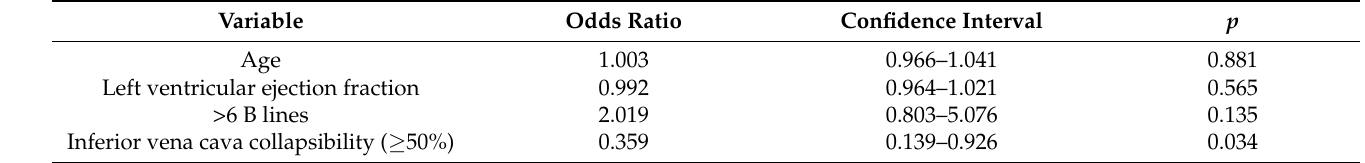
Figure 2. ROC curve of IVC diameter and 30-day mortality for patients with more than 6 B lines on lung ultrasound. Table 3. Logistic regression analysis of clinical and ultrasound variables with 30-day cumulative